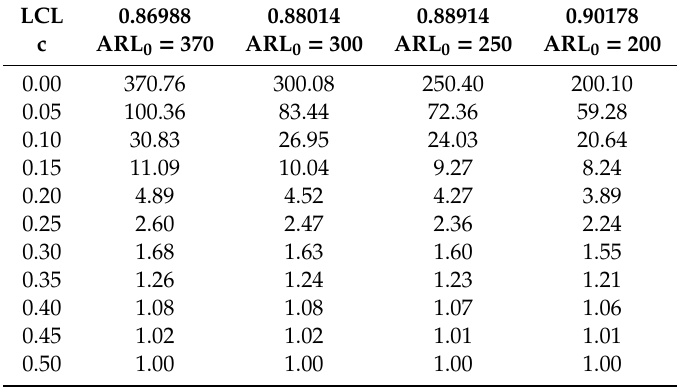
Table 9. The ARLs for the proposed chart when n = 25, GD (3.0,0.75), USL = 6.9553, and LSL =